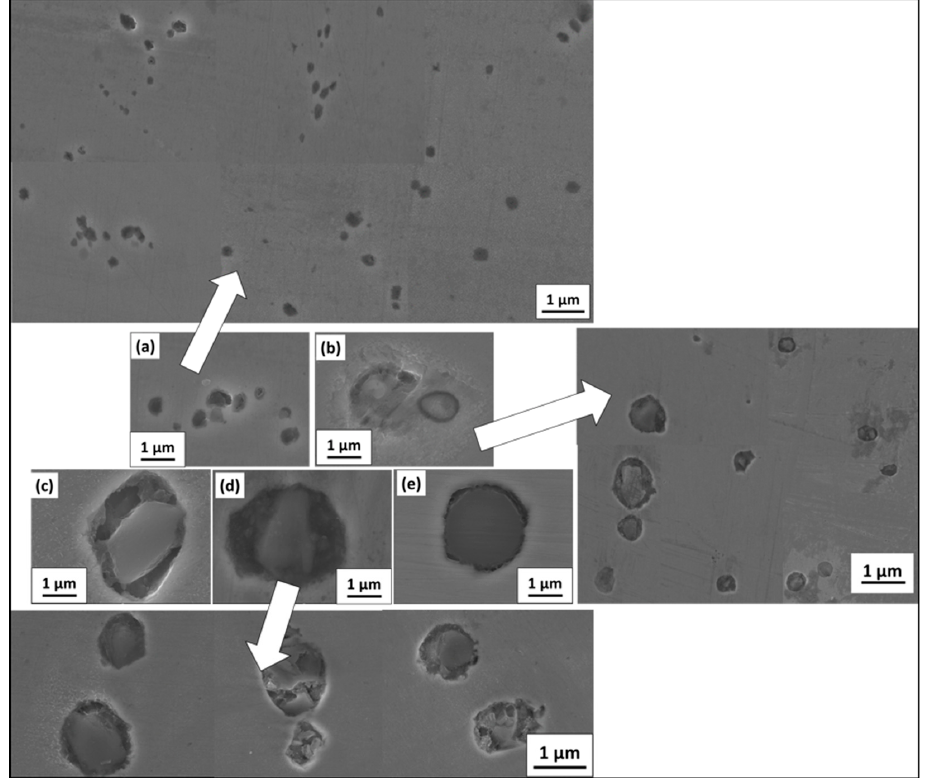
Figure 13. Nonmetallic inclusion size variation under different weld conditions ( a ) S1000V60I35 OD 2 mm, ( b ) S1000V60I35 OD 0.5 mm, ( c ) S800V60I35 WO, ( d ) S1000V60I35 WO and ( e ) S1200V60I35 WO.